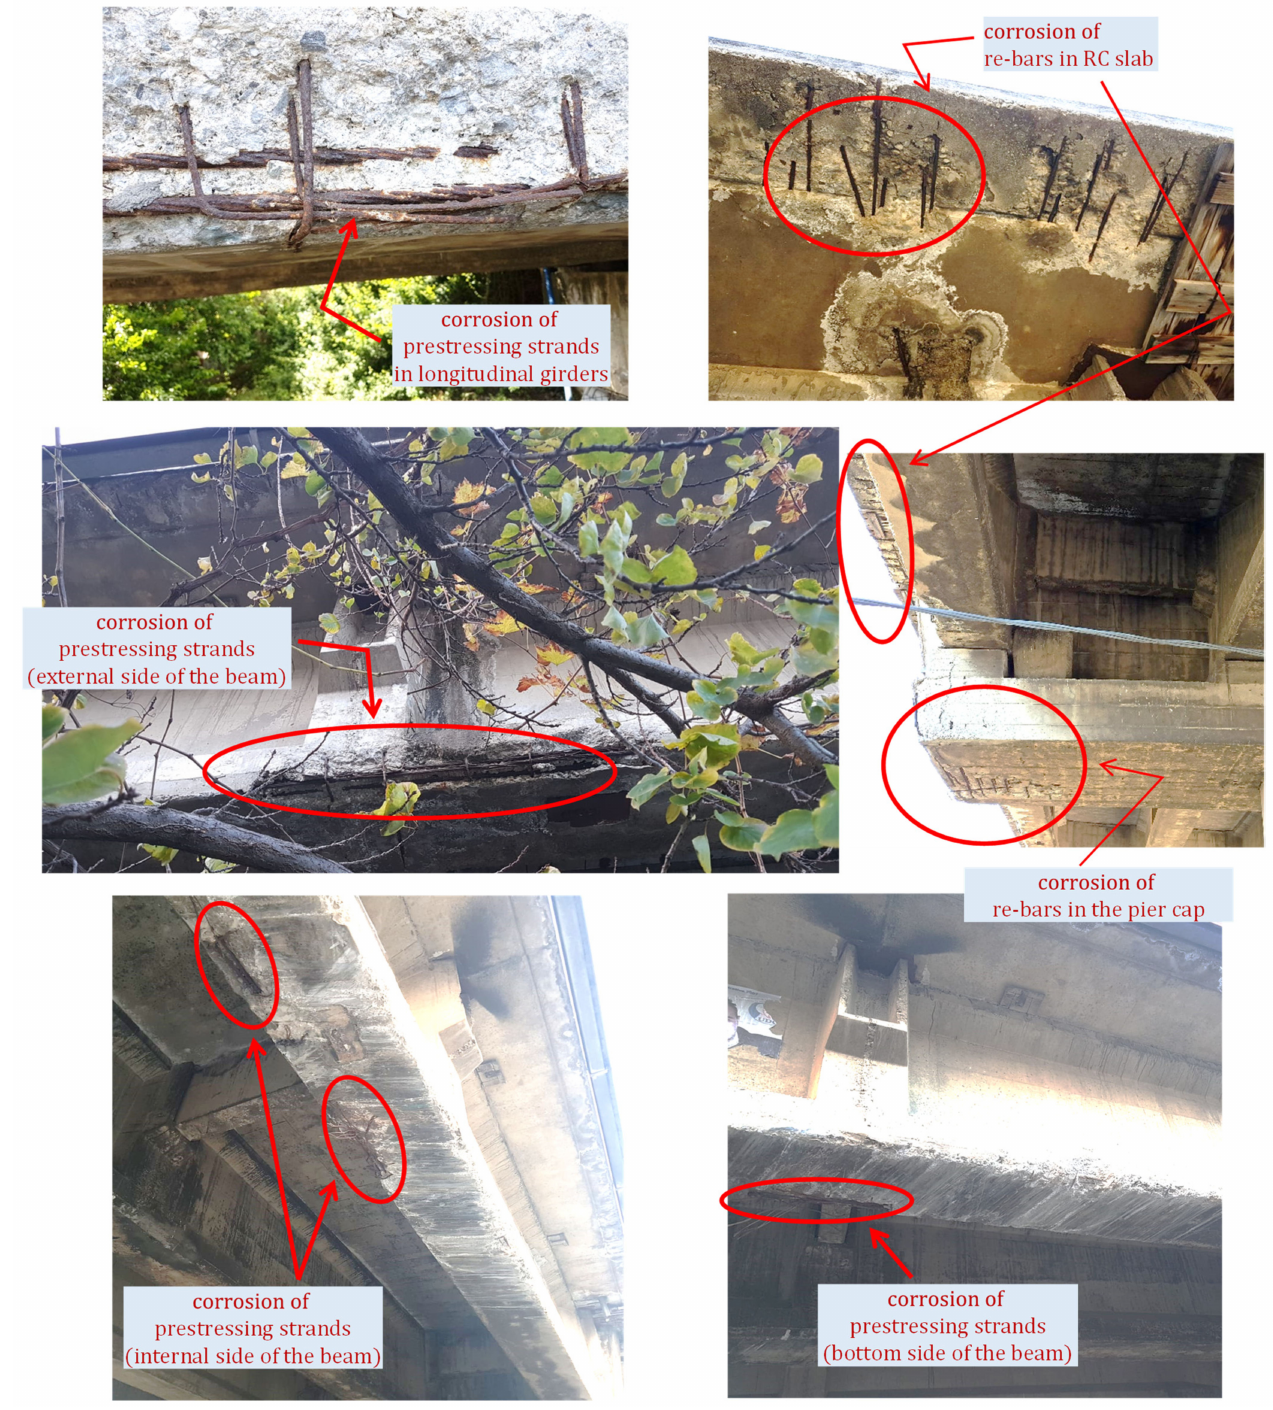
Figure 3. Widespread corrosion state of the Longano viaduct detected from visual